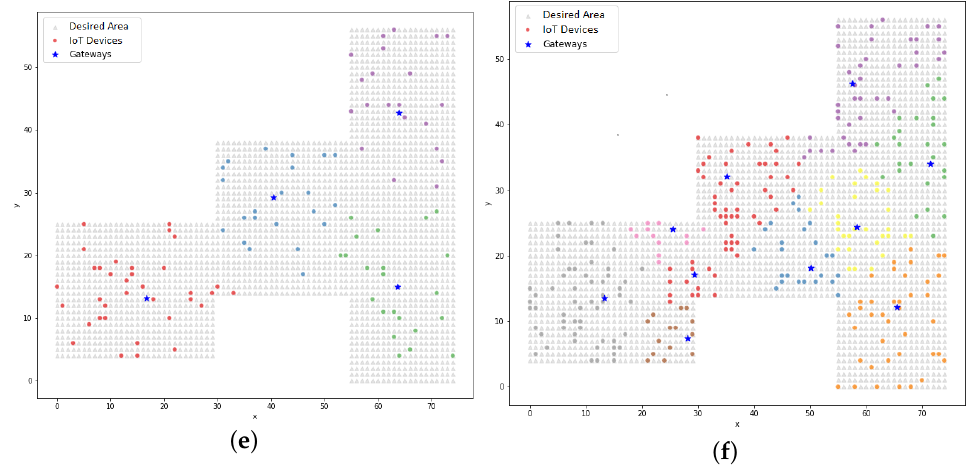
Figure 11. The clustering of IoT devices and their respective gateways using the PSO model (simple approach): ( a ) BLE technology with 100 devices and 35 gateways; ( b ) BLE technology with 300 devices and 37 gateways; ( c ) Wi-Fi technology with 100 devices and 4 gateways; ( d ) Wi-Fi technology with 300 devices and 10 gateways; ( e ) LoRa technology with 100 devices and 4 gateways; ( f ) LoRa technology with 300 devices and 10 gateways.